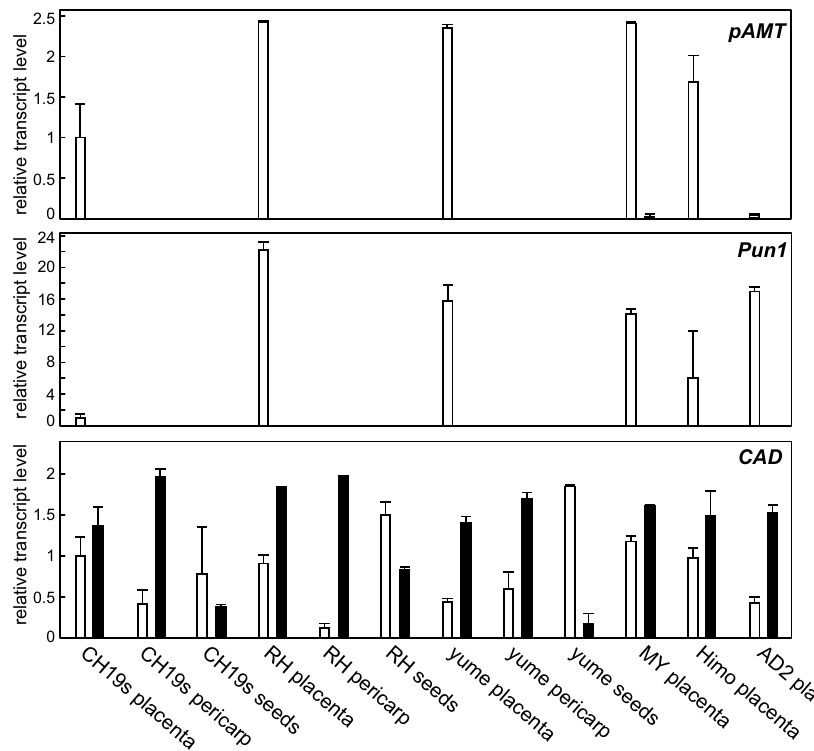
Figure 4. Quantitative real-time PCR analyses of CAD, pAMT, and Pun1 . The transcript levels of pAMT (top), Pun1 (middle), and CAD (bottom) in the placenta, pericarp, and seeds of CH-19 Sweet (CH19s), red habanero (RH), Yume-matsuri (yume), Moruga Yellow (MY), Himo, and Aji Dulce strain2 (AD2) were compared. Expression was normalized against that of average of three control genes. The relative transcript level of each gene was calculated according to the comparative Ct method, with the expression level of each gene in CH-19 Sweet set to 1. White and black bars indicate immature green and mature red fruits, respectively. Each experiment was performed using RNA extracted from three different individual fruits ( n =